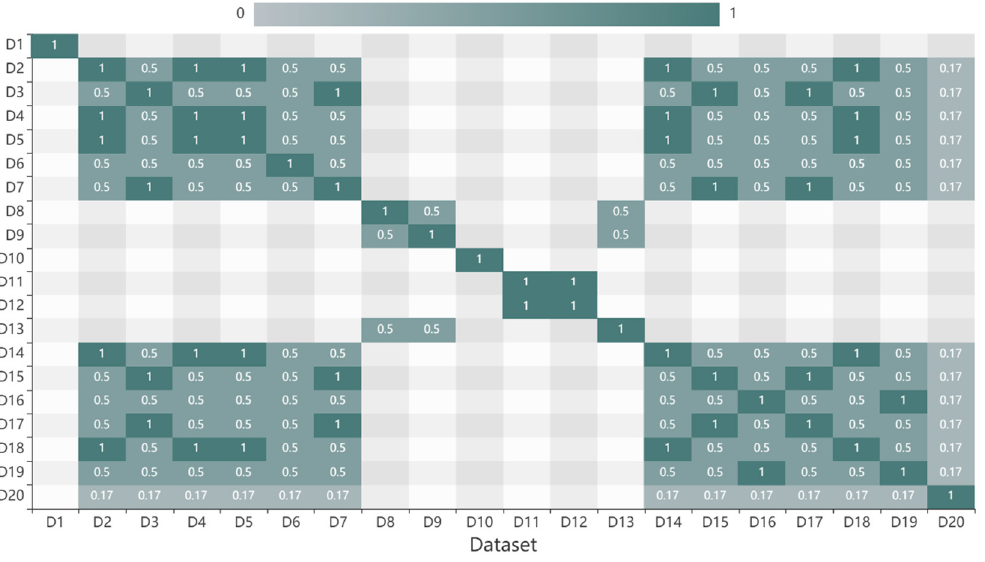
Figure 4. Subject similarities of datasets.